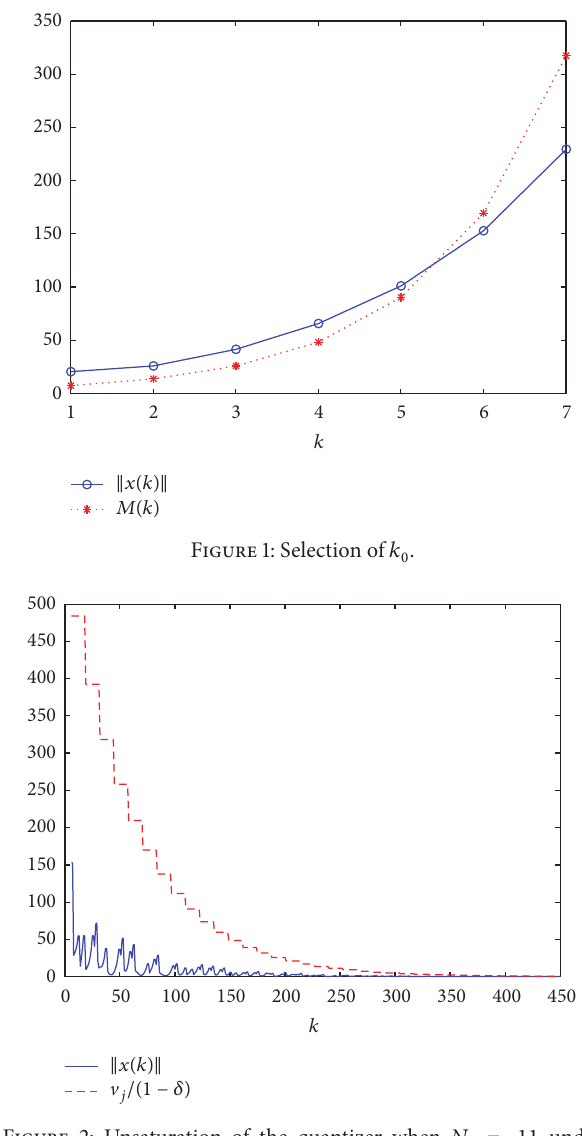
Figure 2: Unsaturation of the quantizer when 𝑁 = 11 under method